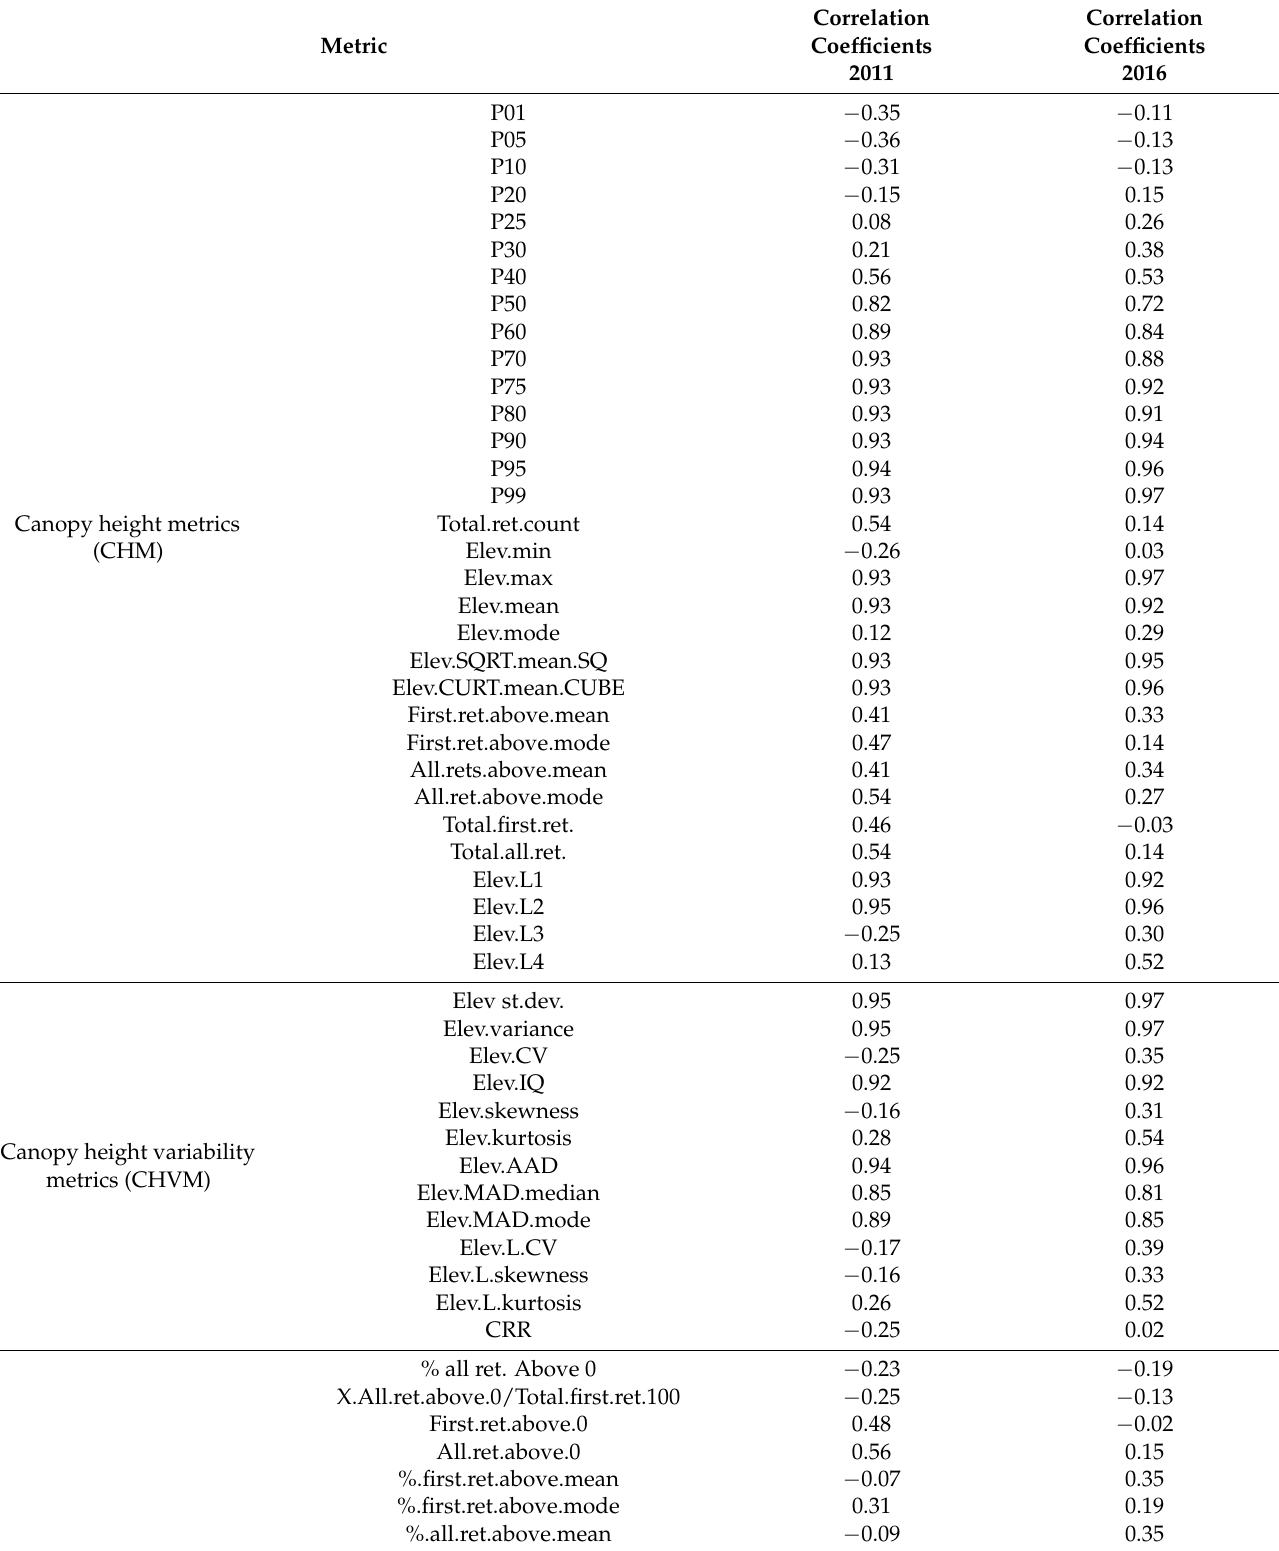
Table 1. Spearman’s correlation coefficients between simulated DART and ALS-PNOA point clouds.